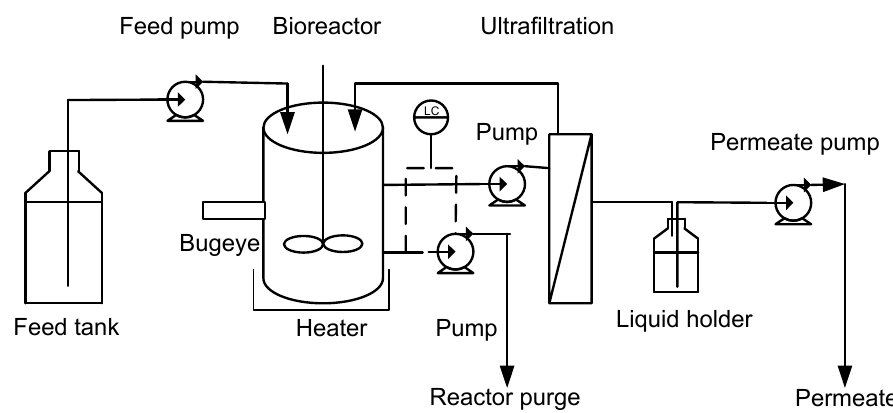
Figure 5. Process diagram of continuous C. tyrobutyricum fermentation/membrane separation